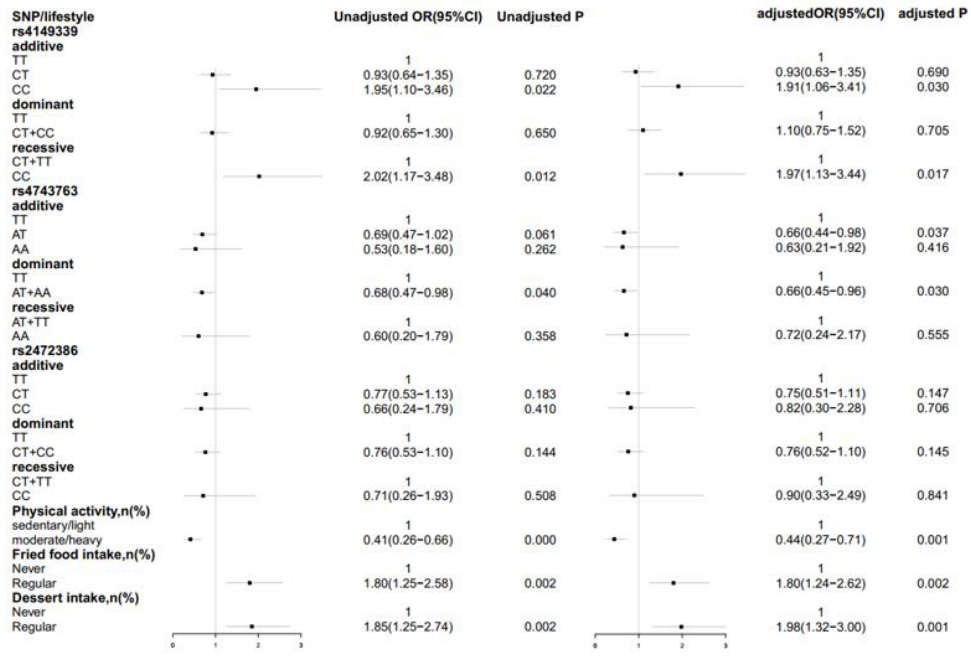
Figure 1. Forest map for the risk of coronary artery disease (CAD) with different genetic models and lifestyle factors. Adjusted for age, sex, waist circumference, smoking, and drinking. p value < 0.05 was considered statistically significant and maintains significance using the Benjamini-Hochberg procedure with the false discovery rate at